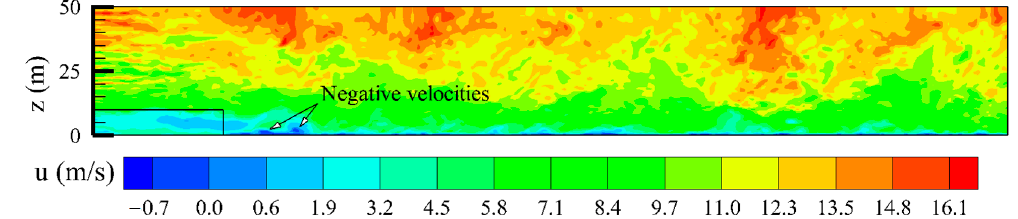
Figure 7. Vertical cross section of the stream-wise velocity field obtained at t = 1000 s, for canopy LAI = 2 and U 10 = 5 m/s, at y = 25 m.